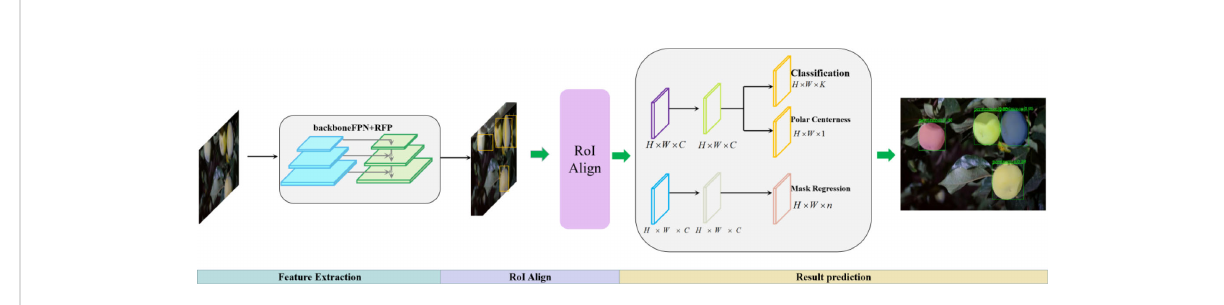
FIGURE 2 Polar-Net structure diagram (including three parts of feature extraction, ROI Align, and result prediction).